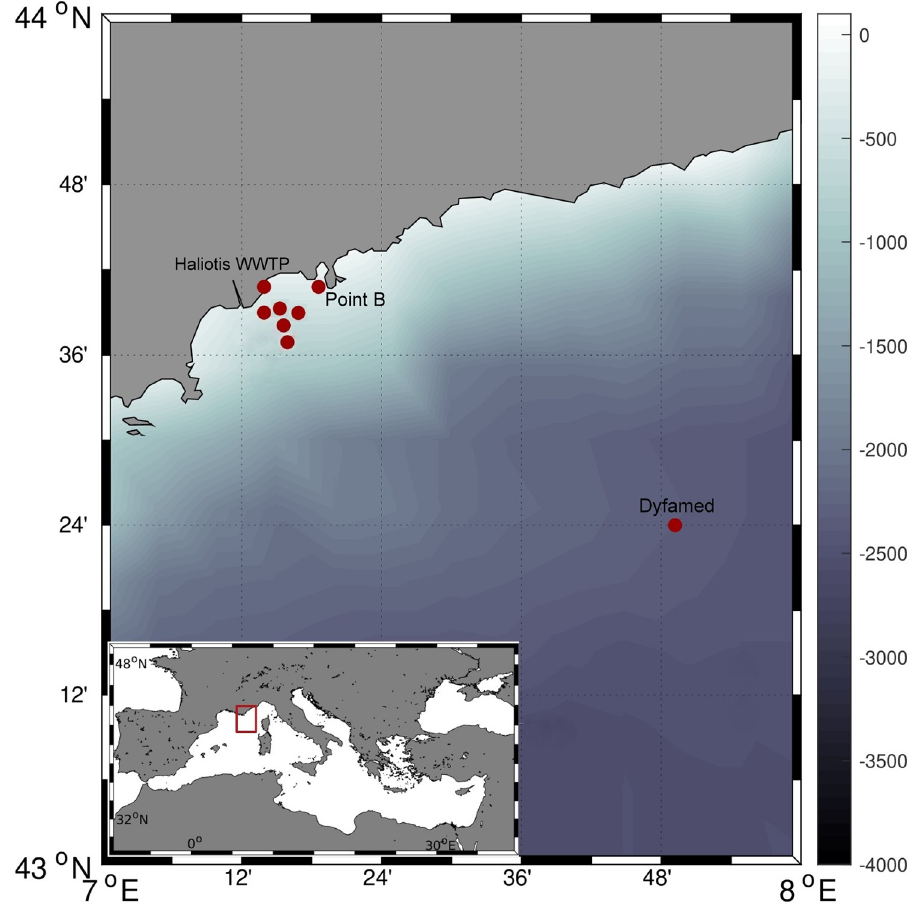
Fig 1. Map of the northwestern Mediterranean Sea where seasonal sampling of MFs and seawater was carried out in the coastal area between Nice and Monaco, as well as in the offshore Dyfamed station, and the Haliotis waste water treatment plant. This map was created at MATLAB software by using the M_Map